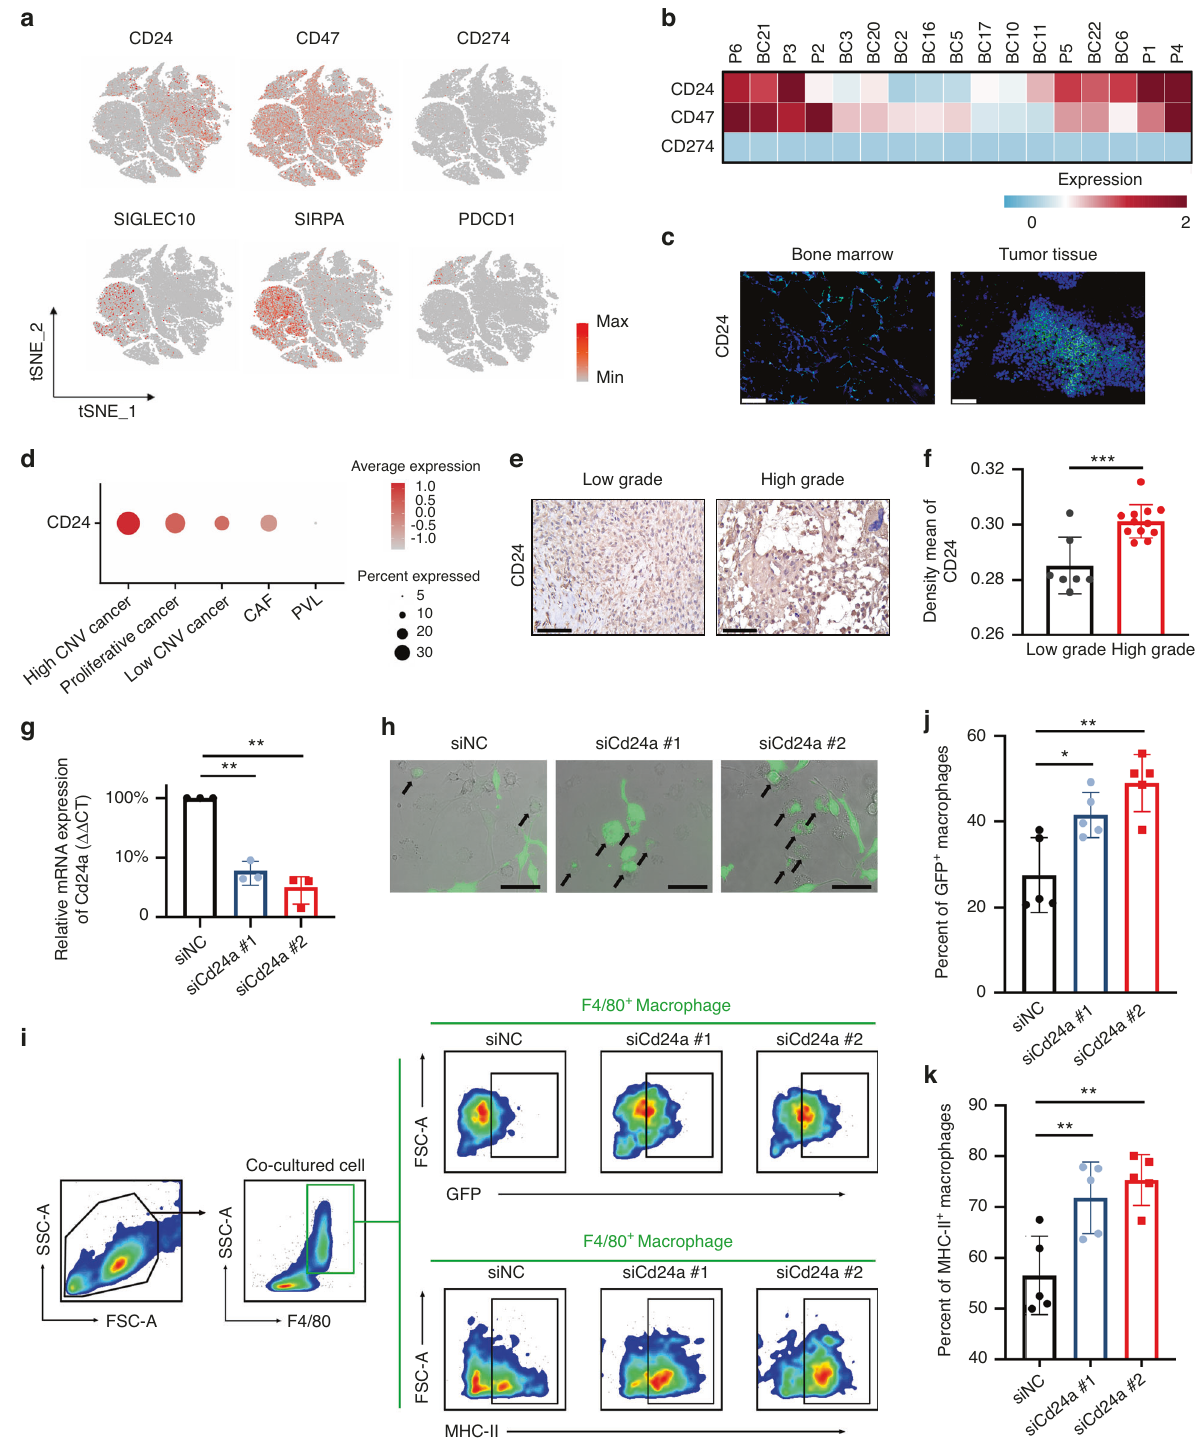
Fig. 5 CD24 protects OS cells from macrophage attack. a Expression of the immune checkpoints CD24, CD47, and CD274 and their receptors overlaid onto tSNE plots. Red represents high expression; gray represents low expression. b Heatmap showing the normalized expression of CD24, CD47, and CD274 in each patient. Red represents high expression; blue represents low expression. c Fluorescence in situ hybridization (FISH) imaging of CD24 in tumor tissues and bone marrow from the patients. The scale bar represents 100 μ m. d Dot plots showing the expression of CD24 in stromal cells. Red represents high expression; gray represents low expression. The size of the circle represents the percentage of cells that expressed the indicated genes. e and f Representative immunohistochemistry and mean density of CD24 expression in low-grade and high-grade OS tissue. Scale bar, 100 μ m. g Relative expression of Cd24a in K7M2 cell lines that were transfected with Cd24a siRNA or scramble siRNA. Scale bar, 100 μ m. Data are the means ±SEMs. * P <0.05; ** P <0.01. h Representative live fl uorescence microscopy images of in vitro phagocytosis of K7M2 cells (GFP + green) by BMDMs in the presence of Cd24a siRNA or scramble siRNA. i-k Representative images of the gating strategy and statistical analysis for the in vitro phagocytosis assay and the M1-like macrophage assay. Data are the means ±SEMs. * P <0.05; ** P